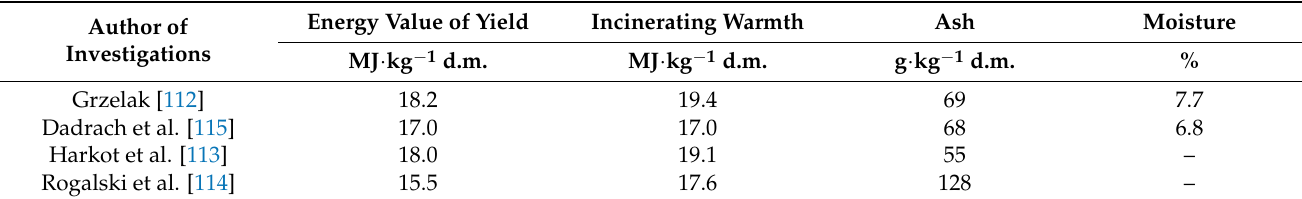
Table 16. Characteristics of energy values of reed canary grass (own